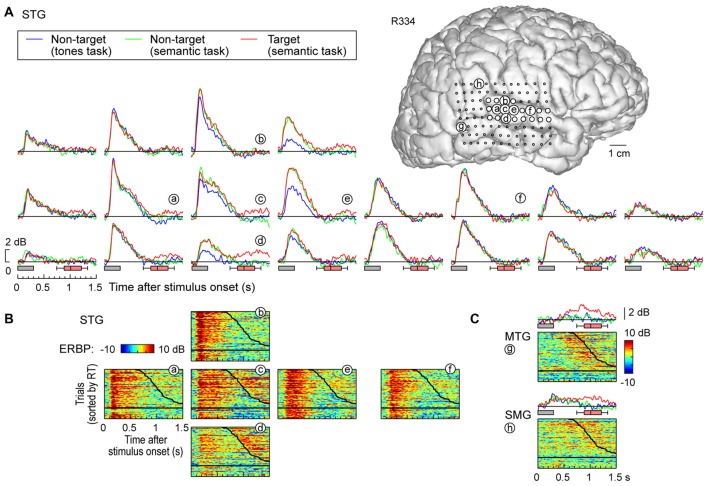
High gamma responses recorded from right lateral temporal cortex in subject R334. (A) Average high gamma ERBP waveforms for superior temporal gyrus (STG) sites, plotted for trials when words (“cat”, “dog”, “five” and “ten”) were non-targets in a tone detection task, non-targets in a semantic categorization task and targets in a semantic categorization tasks (blue, green and red waveforms, respectively). MRI reconstruction of the lateral view of the right cerebral hemisphere depicting the location of the recording sites is shown at the top right. (B) Waterfall plots showing single-trial high gamma ERBP in response to the target stimuli for six representative sites on the STG (a–f). Trials are sorted by RT (top to bottom: shortest to longest). Thick black line indicates RTs for each trial; horizontal black line separates hits (above) and missed trials (below). (C) Average high gamma ERBP waveforms and single-trial high gamma waterfall plots for sites on the middle temporal gyrus (MTG) and supramarginal gyrus (SMG; g,h, respectively).